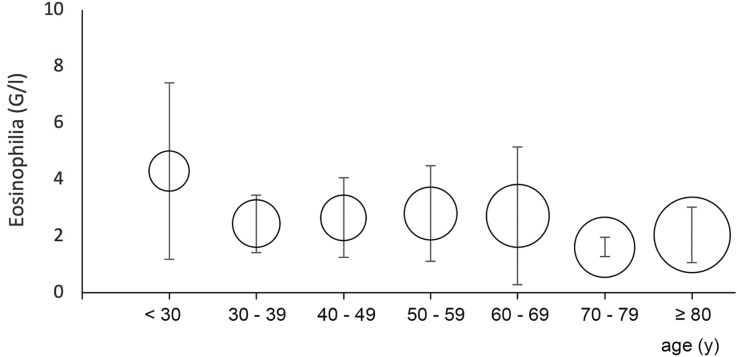
Mean eosinophilia and age.Bars indicate standard derivations around the mean. The center of each circle is placed to the mean eosinophilia of the corresponding age group. The surface of the circles is proportional to the number of patients in the corresponding age group.